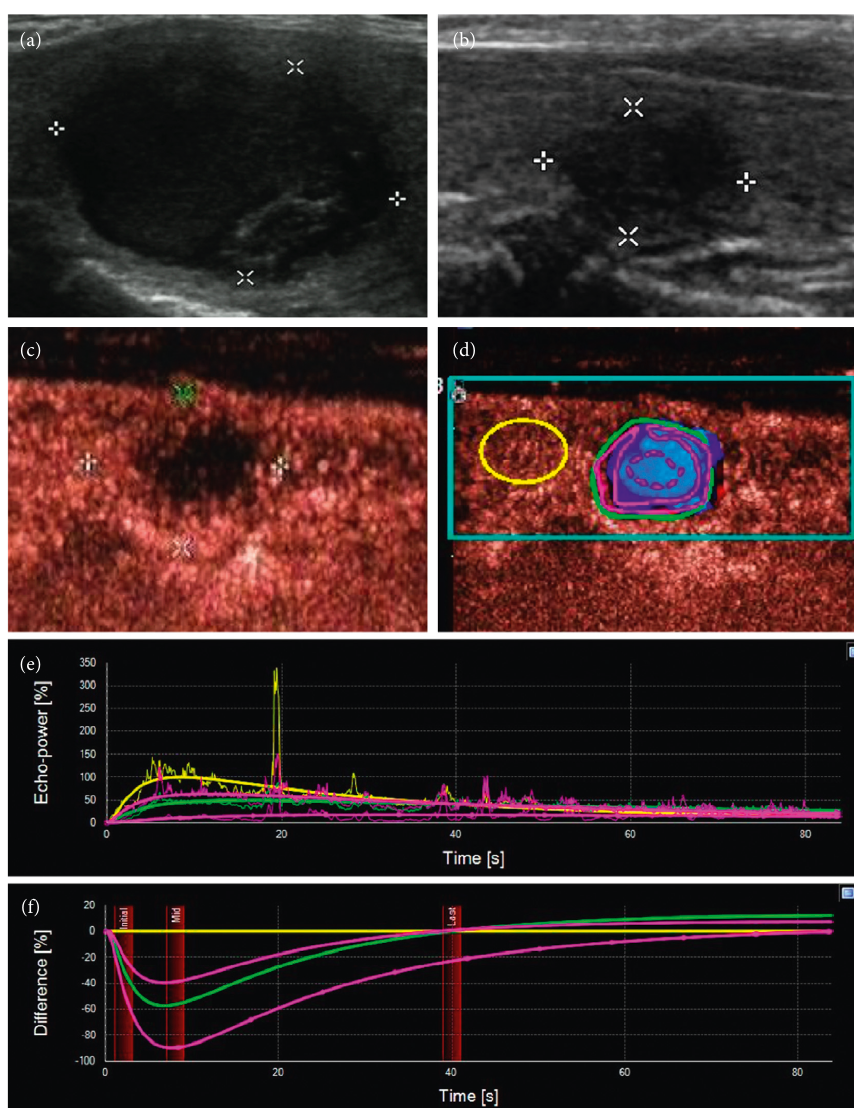
Figure 4: (a) A 53-year-old female had a thyroid nodule with clear margin and the maximum diameter of 21 mm. (b) Two years later, the nodule became smaller and more solid, the margin of the nodule was blurred, and the nodule was classified as TI-RADS 4. (c) CEUS showed that the edge of the nodule was slightly ring-shaped with low enhancement, while the interior of the nodule was uneven with low en- hancement. (d) The contrast video was analyzed using SonoLiver software. (e, f) The time intensity curve and time-difference curve were obtained. It showed that the intensity of the whole nodule, its periphery, and its interior was always lower than those in the control area with time, and the intensity in the central area was the lowest, which was close to no